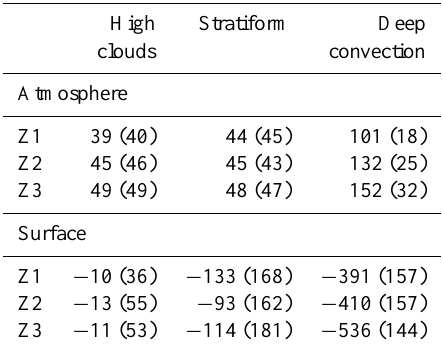
Figure 13. CRE at surface (blue lines) and in the atmosphere (red lines) as a function of ice water path. The dotted lines show stan- dard deviation in each case. The statistics are compiled for the JJAS months over the entire study area northward of the